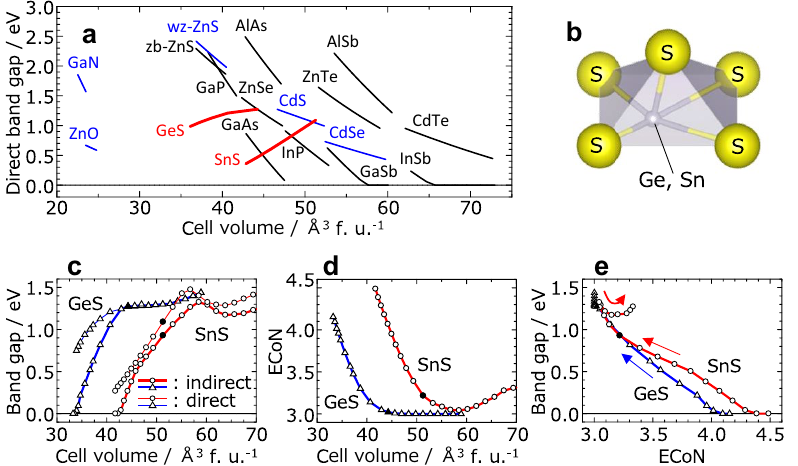
Figure 1. Variation in the bandgap of typical semiconductors and the uncommon behaviour of SnS and GeS. ( a ) Volume dependence of direct bandgap in compound semiconductor materials calculated with GGA-PBE between 0 and 8 GPa. Black and blue lines represent zinc-blende and wurtzite structures, respectively. ( b ) Coordination structure of cations in Pnma -type SnS and GeS. Relationships between ( c ) unit cell volume and bandgap (thin and thick lines denote indirect and direct bandgaps, respectively), ( d ) unit cell volume and effective coordination number (ECoN), and ( e ) ECoN and bandgap of SnS and GeS. Closed marks indicate the values at 0